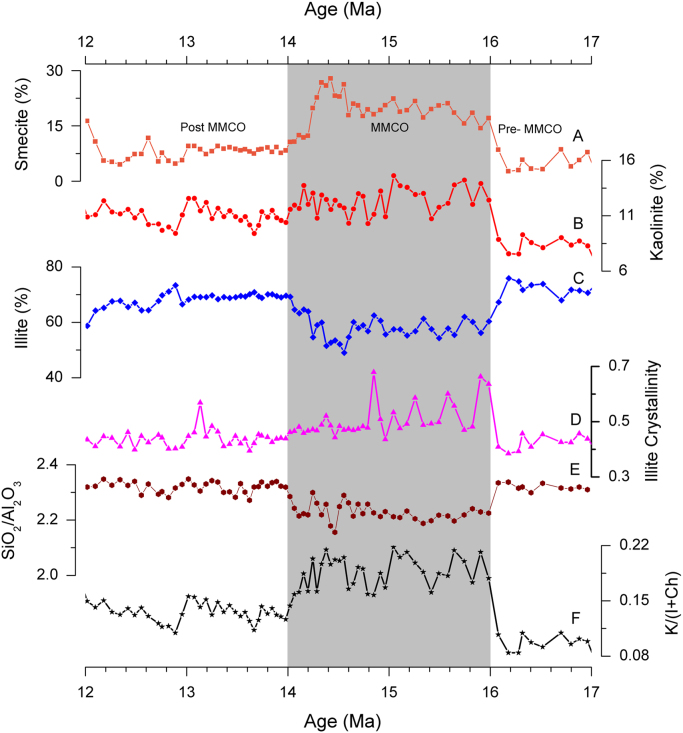
The Variations in clay minerals composition (%), illite crystallinity, SiO2/Al2O3 and K/(I+Ch) of the ZL red clay in the MMCO period. K/(I+Ch)-Kaolinite/(Illite+Chlorite).